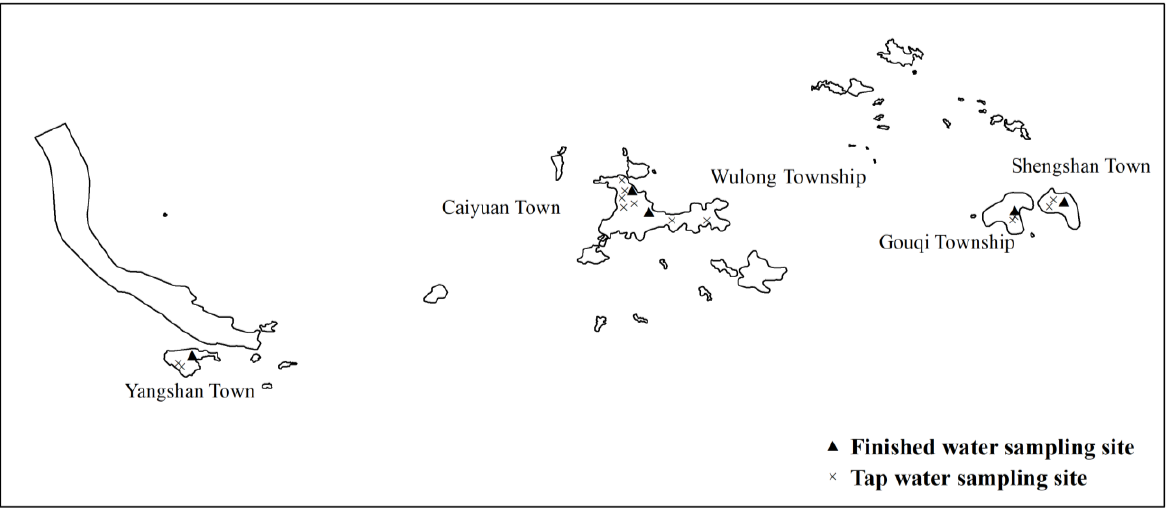
Figure 2. The sampling sites in Shengsi County, China.